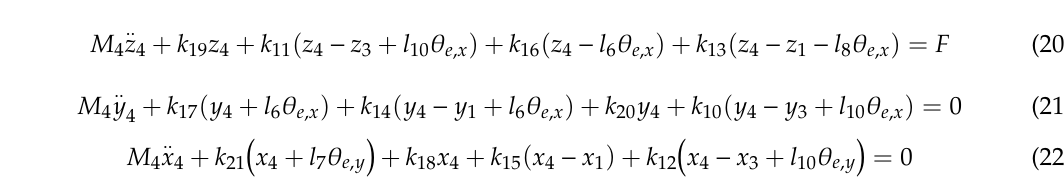
Figure 5. Free-body diagrams of the housing.